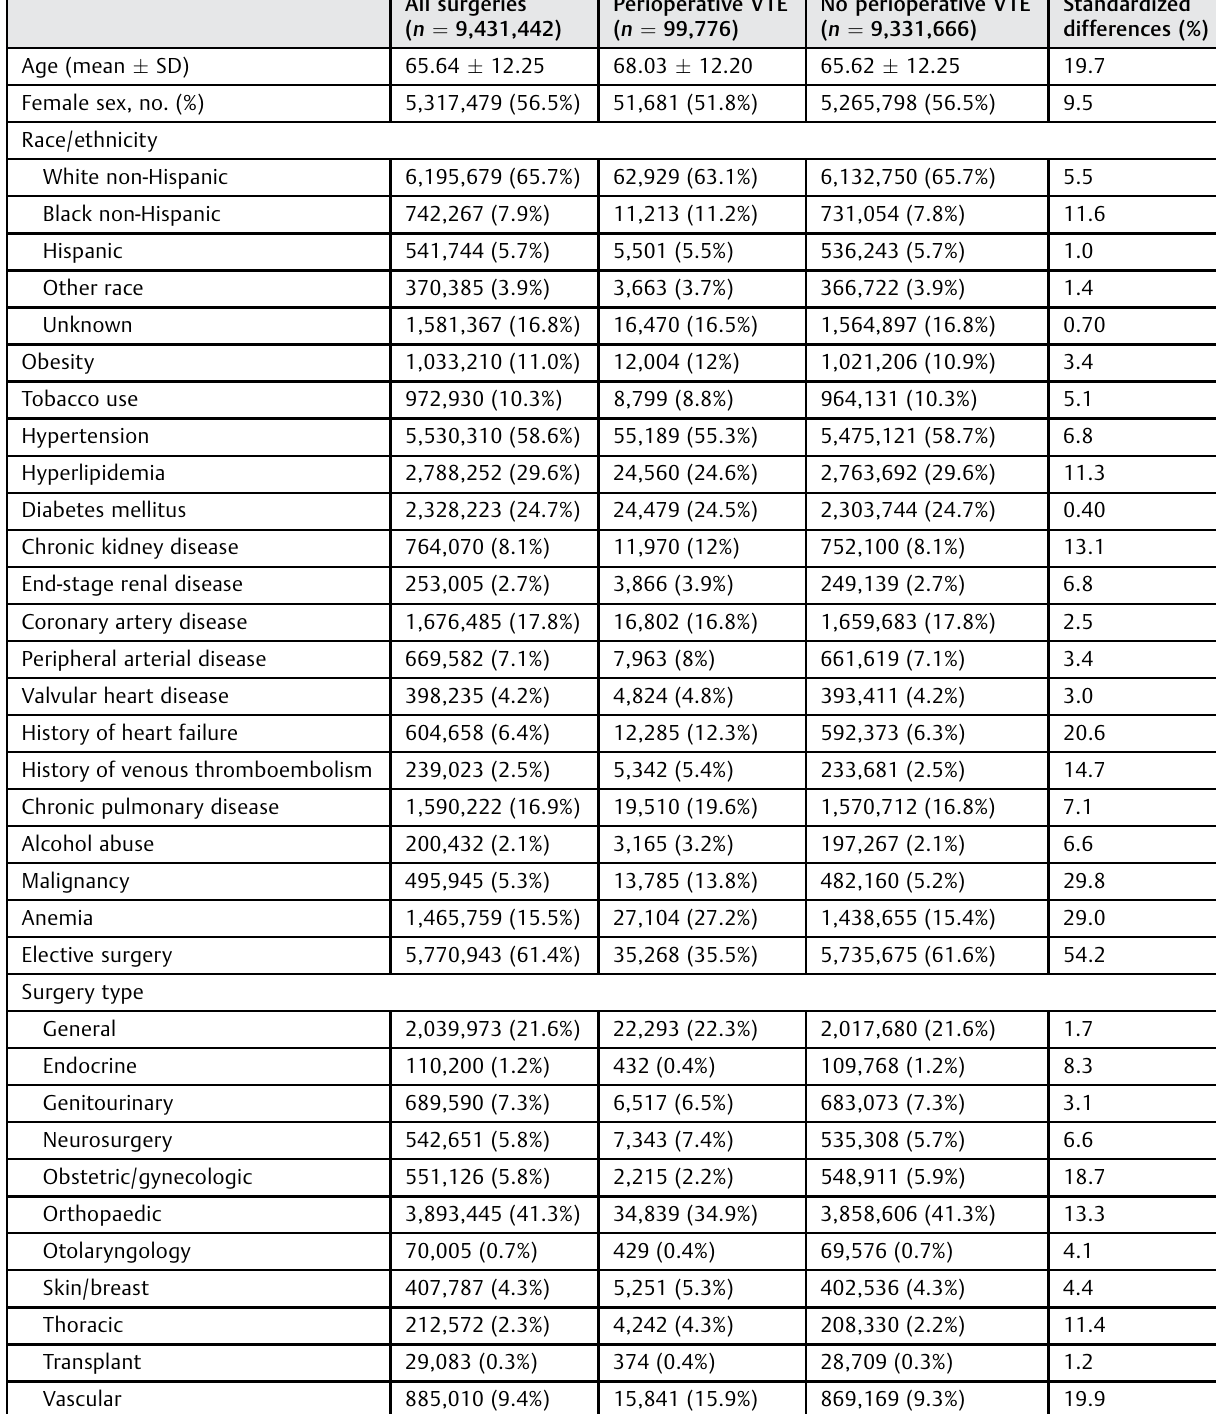
Table 1 Baseline characteristics of patients undergoing major noncardiac surgery with and without in-hospital perioperative venous